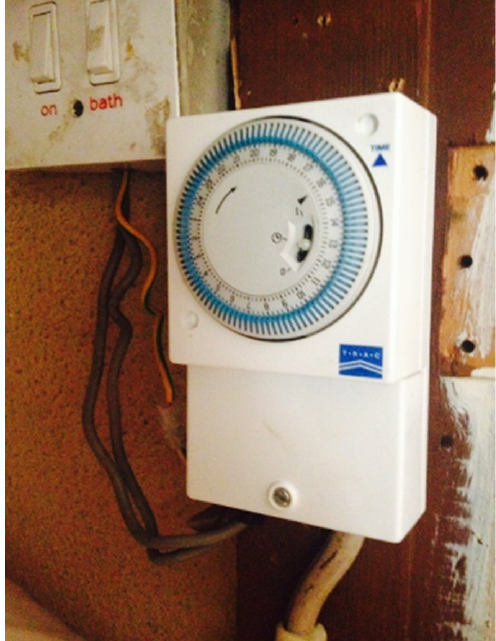
Figure 5. The interior of Joan’s ‘hot-press’, displaying the central heating timer and immersion heater on the left, and torch on the right. Permission granted by Dr. L Shore.